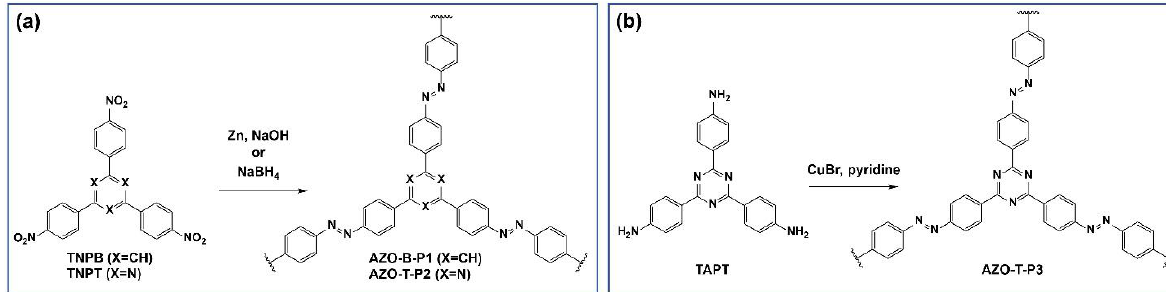
Figure 1. Synthesis of a series of benzene- ( AZO-B-P) and triazine-based (AZO-T-P) azo-bridged polymers by ( a ) Zn- or NaBH 4 -mediated reductive homocoupling of aromatic nitro monomers (TNPB and TNPT); ( b ) copper(I)-catalyzed oxidative homocoupling of aromatic amino monomer (TAPT); ( c ) heterocoupling of aromatic nitro monomers (TNPB and TNPT) and various aromatic diamines under basic conditions. 2. Materials and Methods 2.1. General Information All chemicals were used as received from suppliers. The course of the reactions was monitored by thin-layer chromatography (TLC) (Merck silica gel 60- F254-coated plates). The synthesized compounds were identified by solution 1 H and 13 C NMR spectroscopy, solid-state 13 C CP/MAS NMR spectroscopy, IR spectroscopy, PXRD and elemental analy- sis. Solution-state 1 H and 13 C NMR spectra were recorded on a Bruker Ascend 400 MHz NMR spectrometer in DMSO-d 6 . Solid-state 13 C CP/MAS NMR spectra were recorded on